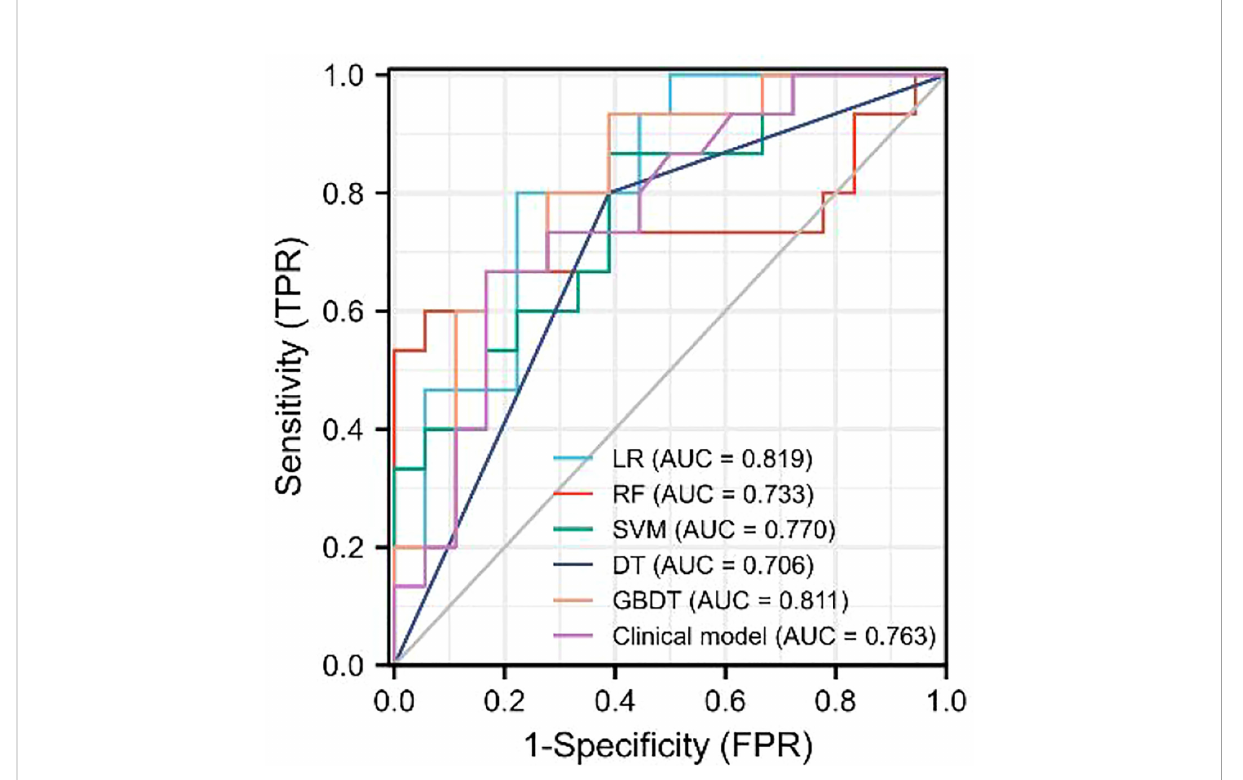
FIGURE 4 ROC curves of the fi ve machine learning models and clinical model in the validation